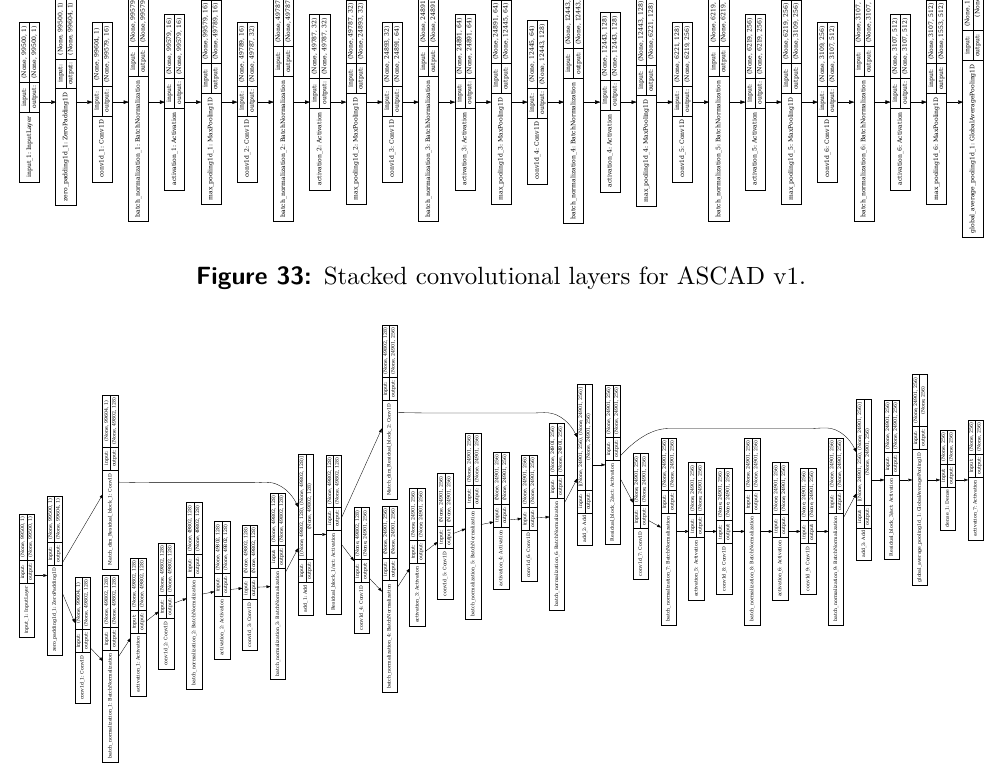
Figure 34: Zhou’s ResNet. We implement this according to their